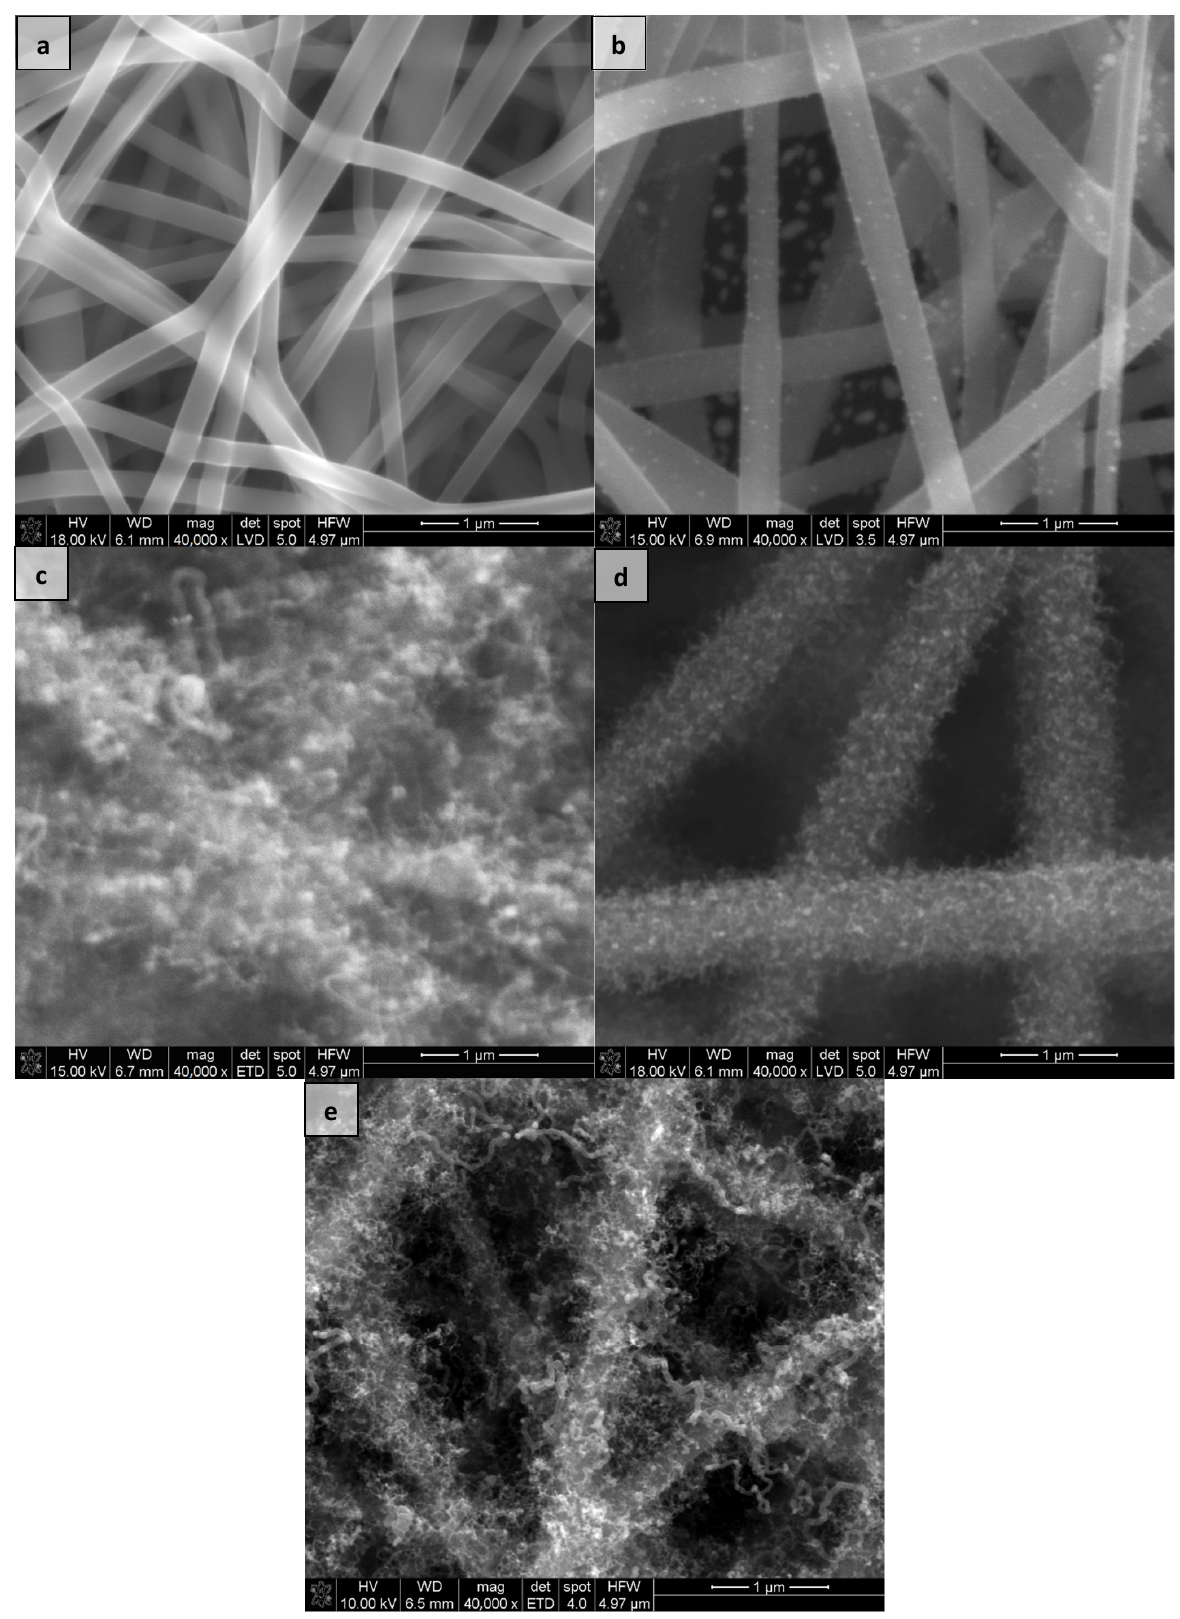
Figure 1. SEM images of ( a ) eCNF, ( b ) eCNF-Co, ( c ) eCNF/CNT[HD]-Co, ( d ) eCNF/CNT[HD]-NiCo, ( e )